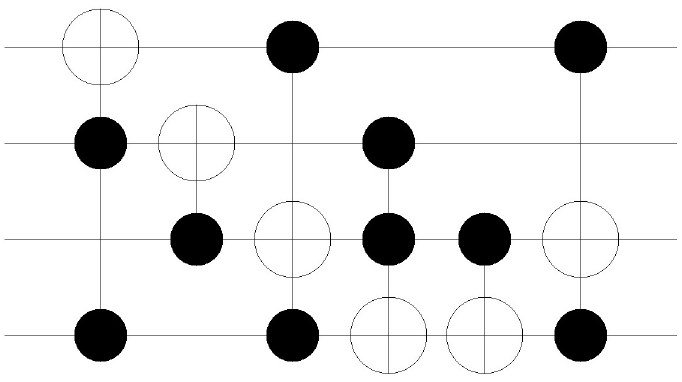
Fig 12. Resulting circuits of No. 18 mini_alu with varying N